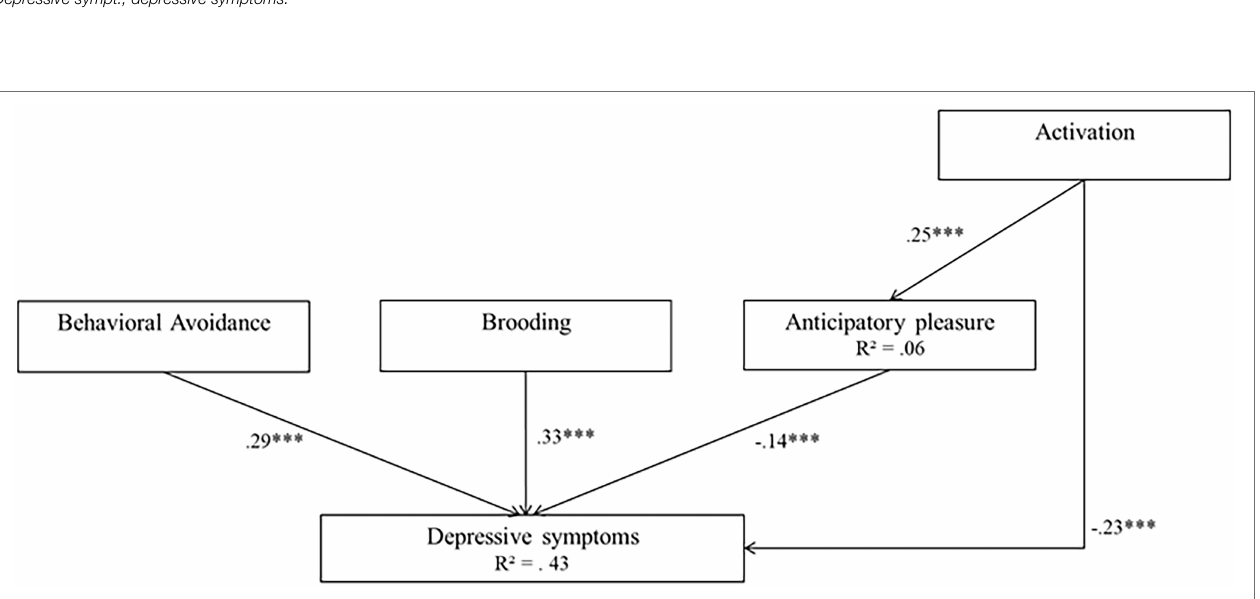
FIGURE 4 | Model 2 (behavioral model 2). Initial structural equation model. Rectangles represent observed measured variables. Values are path-standardized coefficients. R 2 represents the proportion of the variance for a dependent variable that is explained by an independent variable or variables in a regression model. *** indicates a significant path coefficient at p < 0.01. * indicates a significant path coefficient at p < 0.05. (black: p < 0.05; gray: p > 0.05).